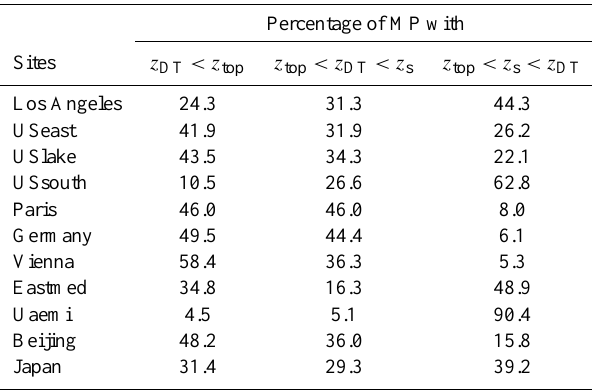
Table 2. Percentage of MP profiles for the three cases where z DT < z top , z top < z DT < z s , z top < z s < z DT